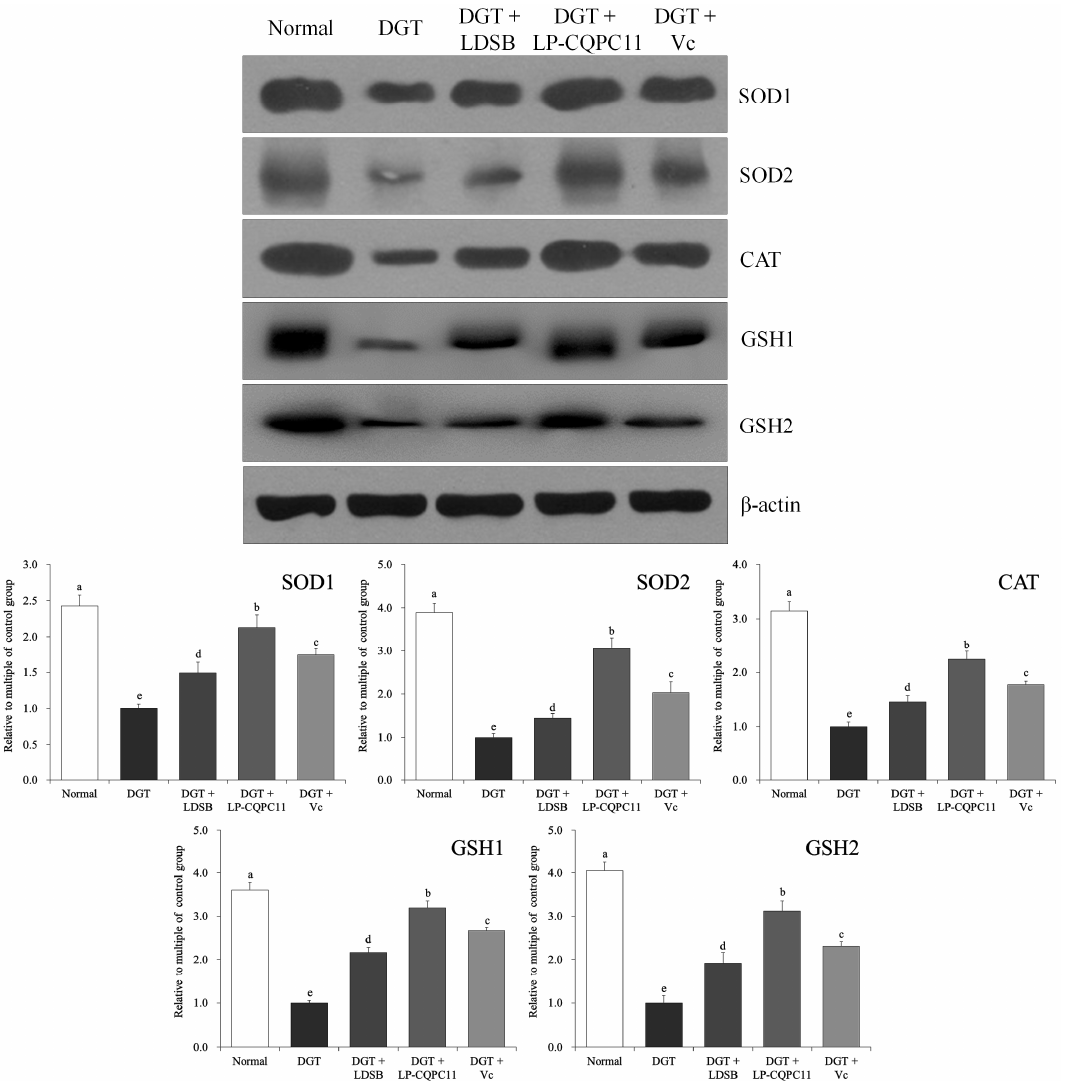
Figure 7. The protein expression in spleen of mice. a–e The different letters mean that there are significant differences ( p < 0.05) between every two groups according to Duncan’s multiple range test. DGT: mice treated with D -galactose; DGT + LDSB: mice treated with D -galactose and Lactobacillus delbruechii subsp. bulgaricus (1.0 × 10 9 CFU/kg); DGT + LP-CQPC11: mice treated with D -galactose and Lactobacillus plantarum CQPC11 (1.0 × 10 9 CFU/kg); DGT + Vc: mice treated with D -galactose and vitamin C (200 mg/kg).